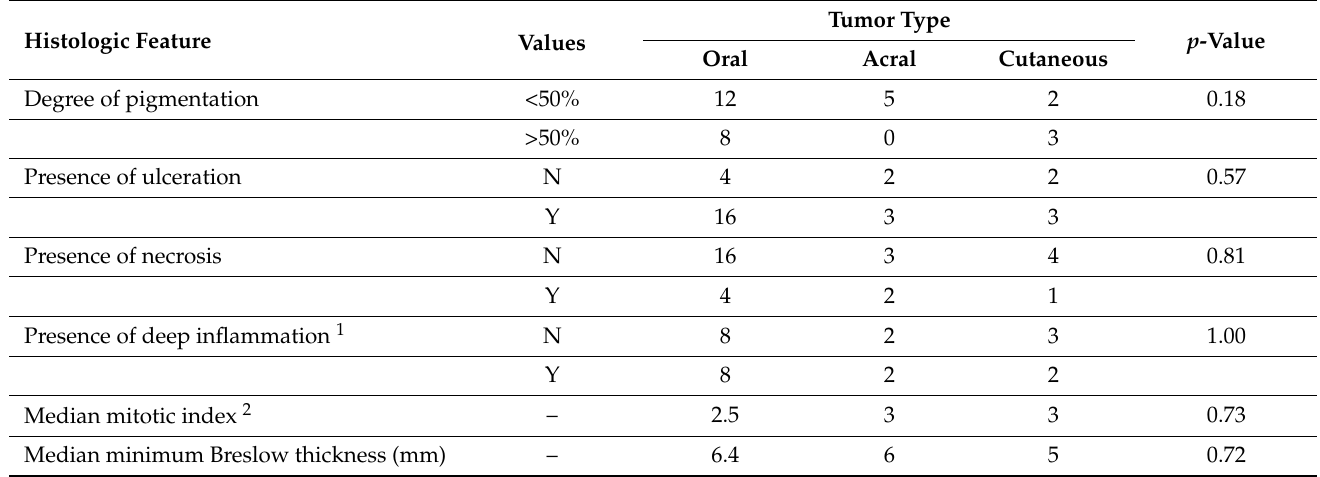
Table 1. Summary of histologic features evaluated by type of canine